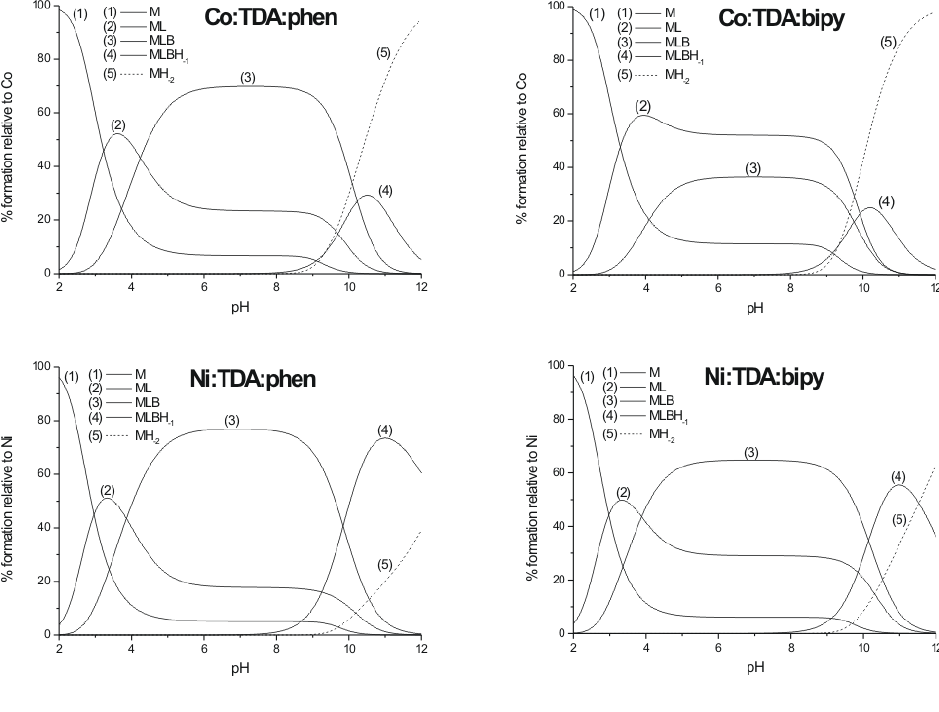
Figure 2 : Species distributions as a function of pH of 1:1:1 M:L:B calculated form the stability constants listed in Table 1. ) of binary and ternary complexes of Co(II) or Ni(II) with TDA and B (phen or bipy) obtained Table 1 : Logarithms of the stability constants (log β pqrs by adapting the equilibrium model to PT data. The standard deviations are given in